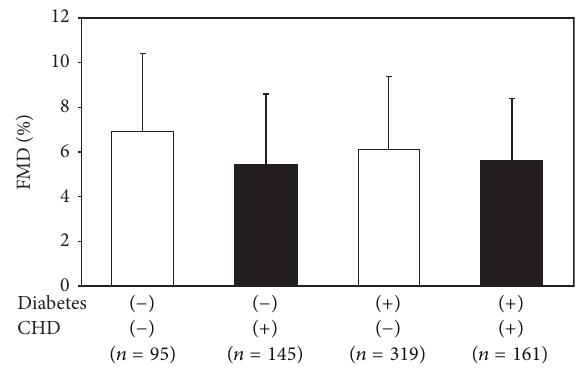
Figure 1: A comparison of the FMD in the groups with and without type 2 diabetes mellitus and